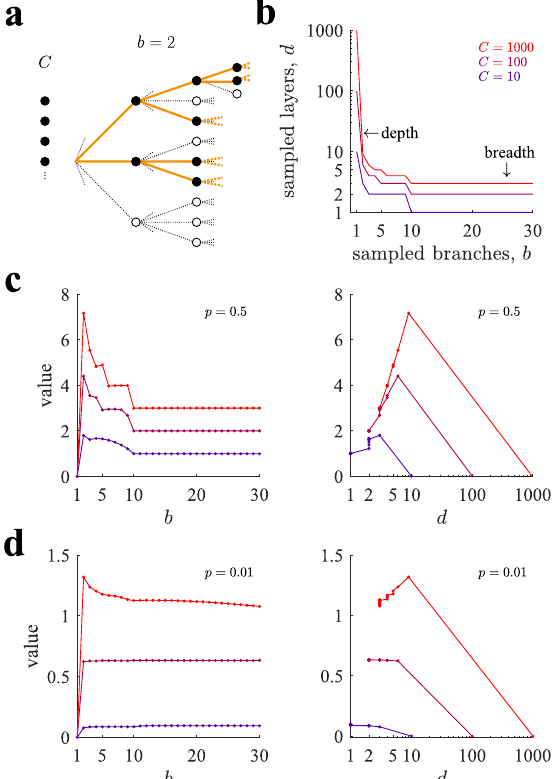
Figure 5. Optimal breadth-depth tradeoffs in sampling decision trees with finite capacity. ( a ) An agent chooses the number of branches that will be sampled, b , per reached node from the root node and continues to sample the tree until capacity is exhausted ( homogeneous selective allocation). The last nodes are sampled stochastically, so that on average the number of samples equals capacity C . In the example the number of sampled branches is b = 2 . ( b ) At fixed capacity, there is a tradeoff between the number of sampled branches and the number of sampled levels. Three values of C have been chosen ( C = 10, 100, 1000 ), representing low, medium and high search capacity. For the same number of sampled branches, the number of sampled levels increase with C . The number of sampled levels includes the last level, which might only be partially sampled. Transitions between plateaus occur when the last level is filled up completely with samples. ( c ) Left panel: Value of playing the tree by choosing to sample b branches per reached node with three different values of capacity for p = 1 2 . Note that for each line, selecting b determines the depth of the played tree d (see panel (b)) due to the finite capacity constraint. The optimal value is attained when the number of sampled branches is b = 2 . Right panel: same data as in the right panel are re-plotted as a function of the depth d of the considered sub-tree. The second longest depth allowed given finite capacity is the optimal allocation to play the tree, which corresponds to b = 2 in the left panel. The curve shows some vertical jumps because the tree value changes as a function of b even though it does not change d . ( d ) Same as in panel (c) for p = 0.01 . While at high capacity sampling the tree with a low number of sampled branches remains optimal, at lower capacities it is best to play the tree by favoring breadth over depth. In all panels, points correspond to simulations (average over 10 6 runs) and solid lines correspond to theoretical predictions by Eqs. (4–6) and Eqs. (6,17,18,25,26) (Sect. “Value of exhaustive or selective search in a large tree with rational p ” of the Methods) for the homogeneous allocation